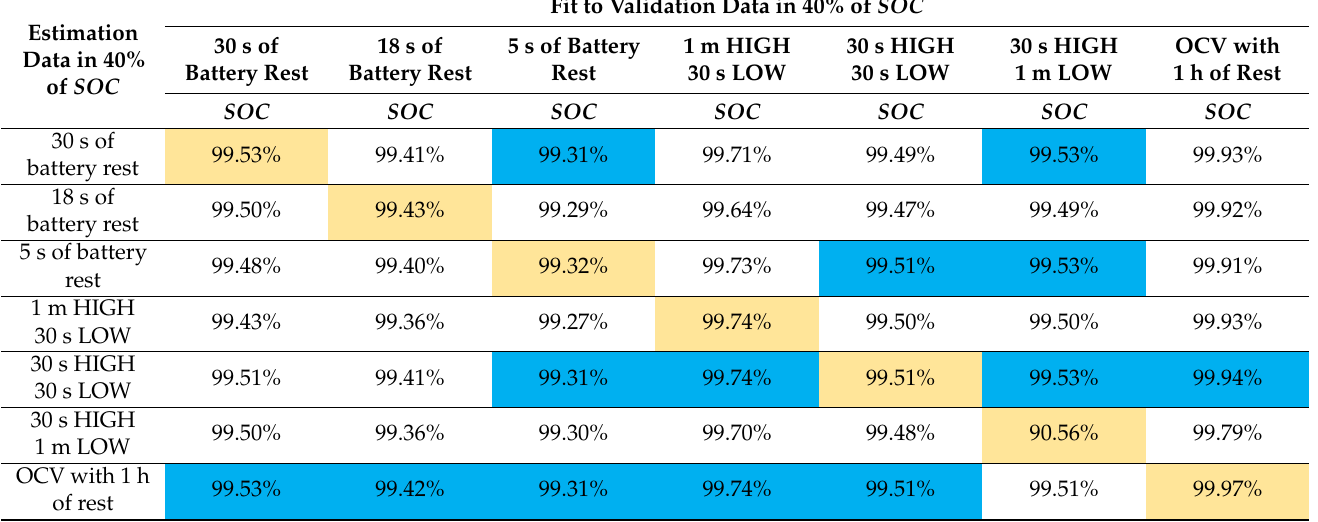
Table 2. Comparison between all experiment’s designs, related to estimation and validation data, considering the output SOC